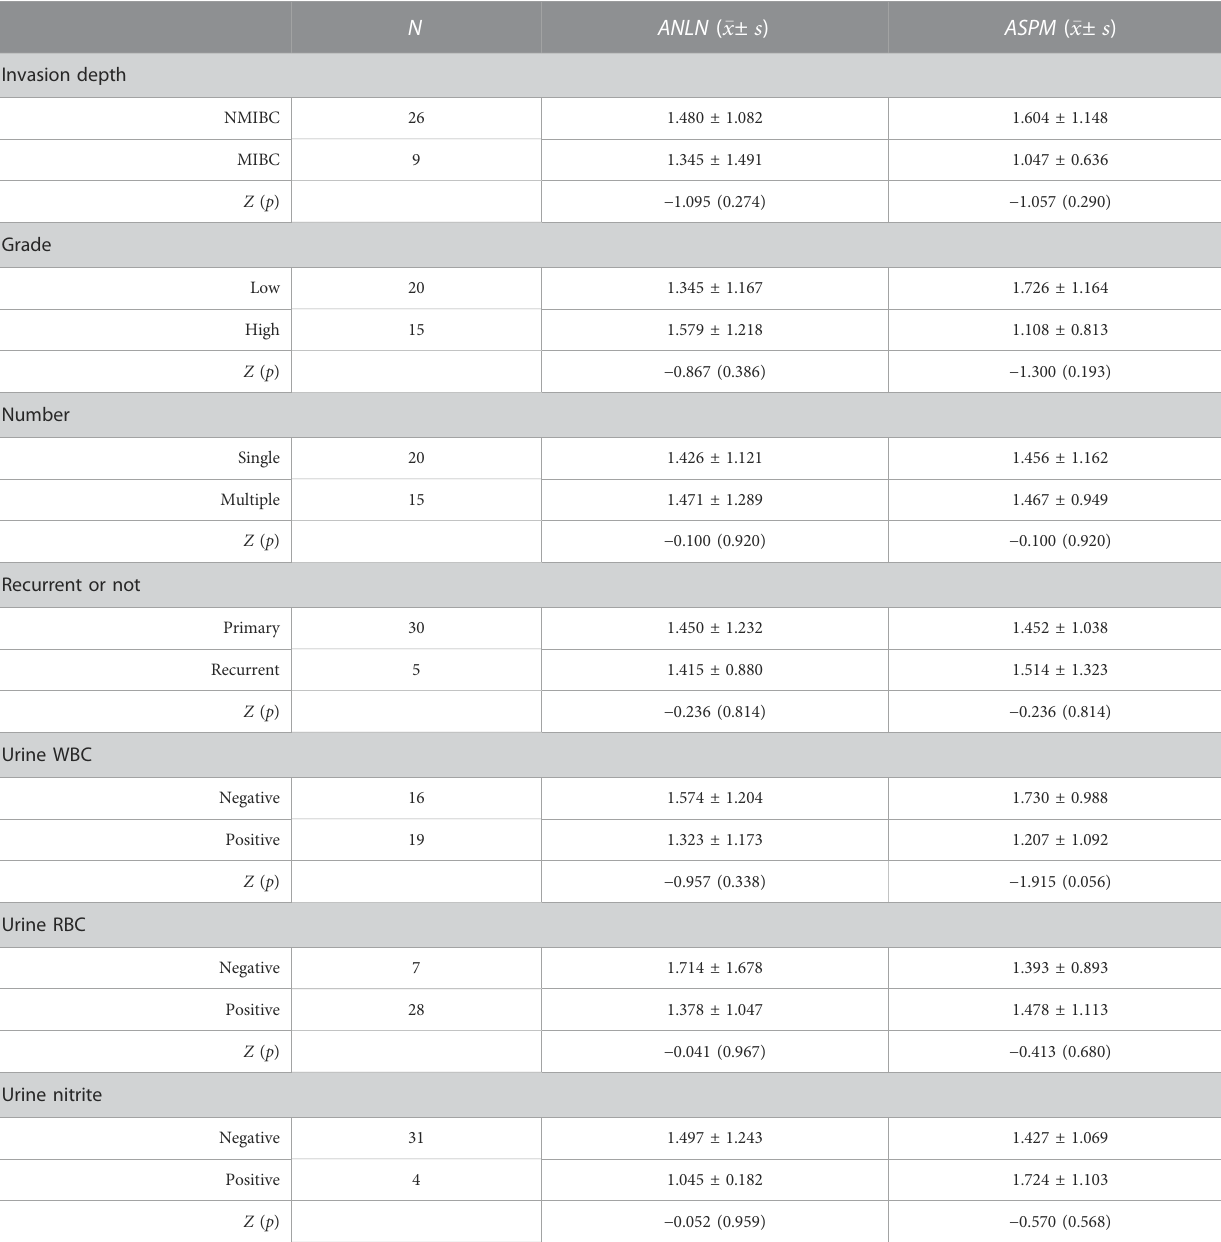
TABLE 5 Relationship of the expression levels of ANLN and ASPM genes with clinicopathological characteristics in bladder